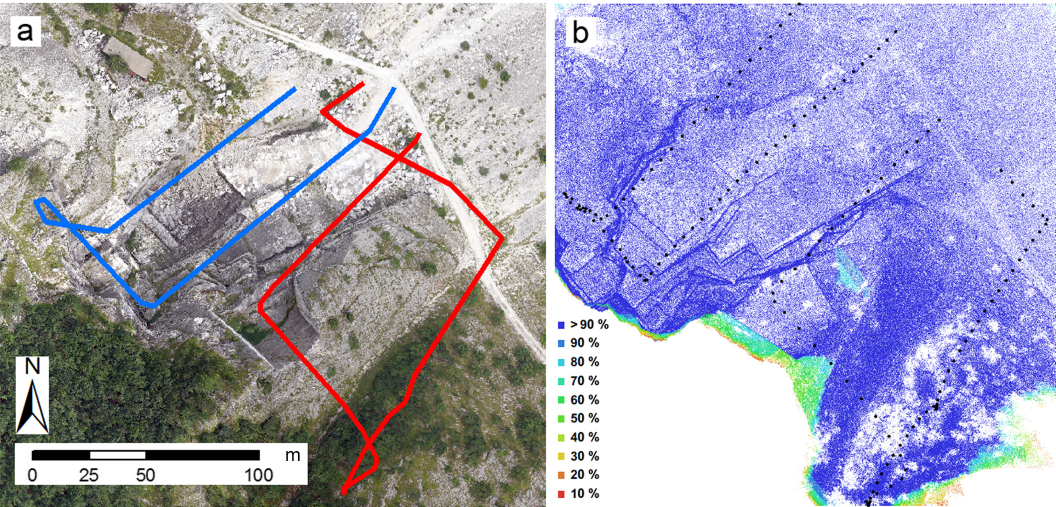
Figure 3. Flight paths of the RPAS zenithal surveys (a) . Plan view of the area with indication of camera locations (black dots) and image overlap percentage (b) .